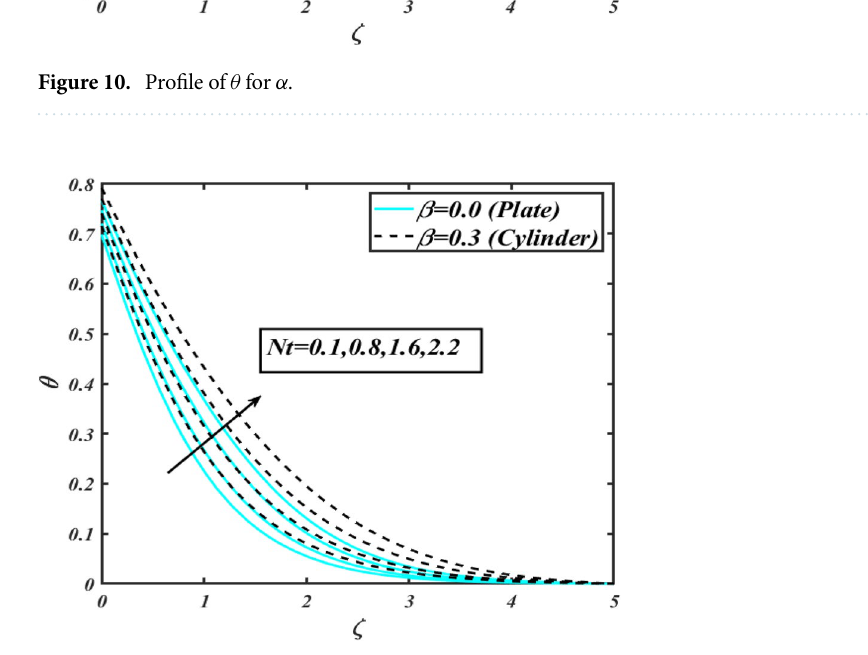
Figure 11. Profile of θ for Nt